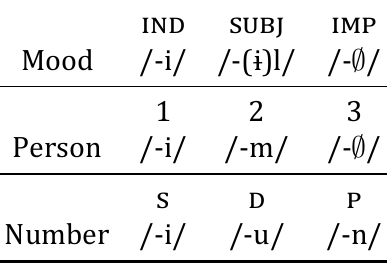
Table 3: Mood, focal person and number markers in